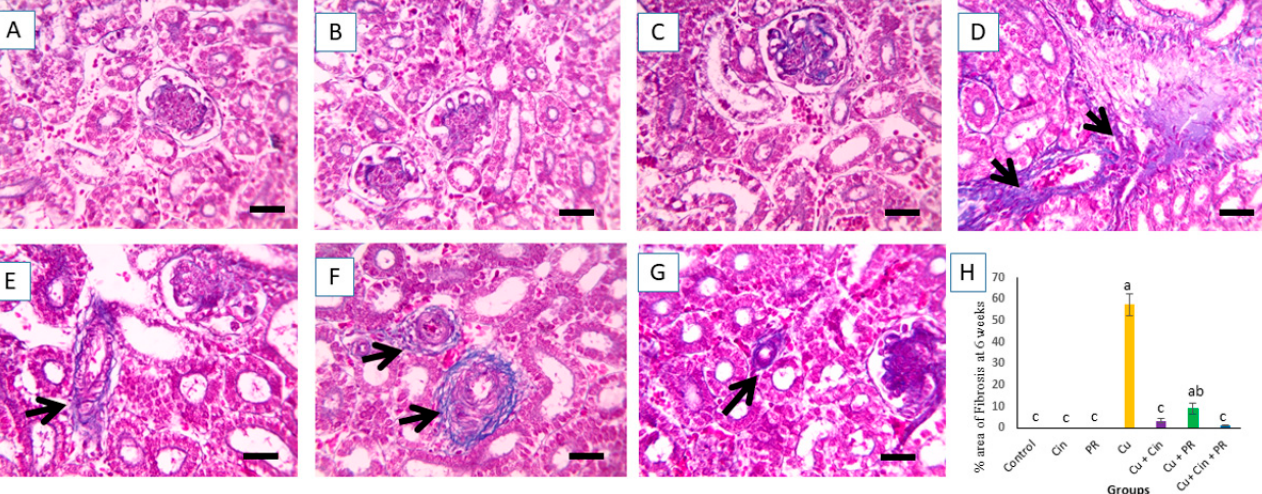
Figure 7. Light photomicrographs of chicken kidney sections (stained with Masson’s trichrome, X 400) after 6 weeks of the experiment. ( A – C ) control group ( C ), cinnamon group (Cin), and probiotic group (PR): with no fibrosis. ( D ) Copper group (Cu): elucidating interstitial fibrosis (black arrow). ( E ) Cu + Cin group: showing significant decrease in fibrosis than Cu group ( p < 0.05). ( F ) Cu + PR group: revealing slight reduction in fibrosis compared to Cu group. (G) Cu + Cin + PR group: presenting significant decrease in fibrosis than Cu group ( p < 0.05). ( H ) Percent of area with fibrosis. Data are expressed as mean ± SEM. Each bar carrying different letters (a,b,c) is significantly different ( p < 0.05). Scale bar = 50 µm.